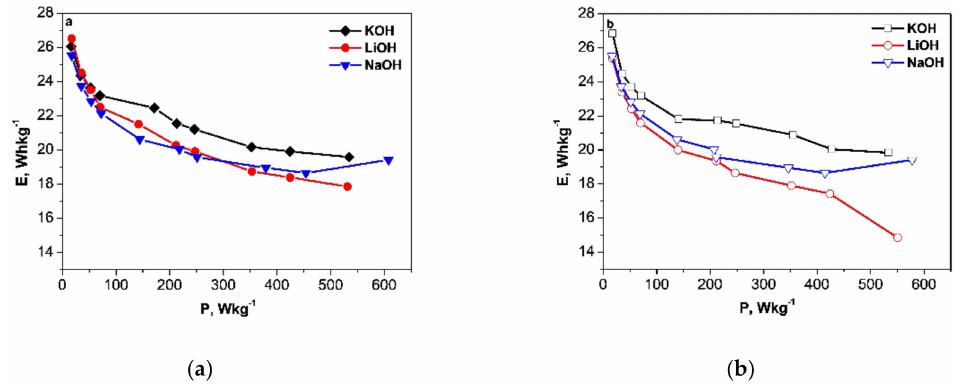
Figure 4. Ragone plots of energy density versus power density for symmetric supercacapacitors with YP-50F ( a ) and YP-80F ( b )